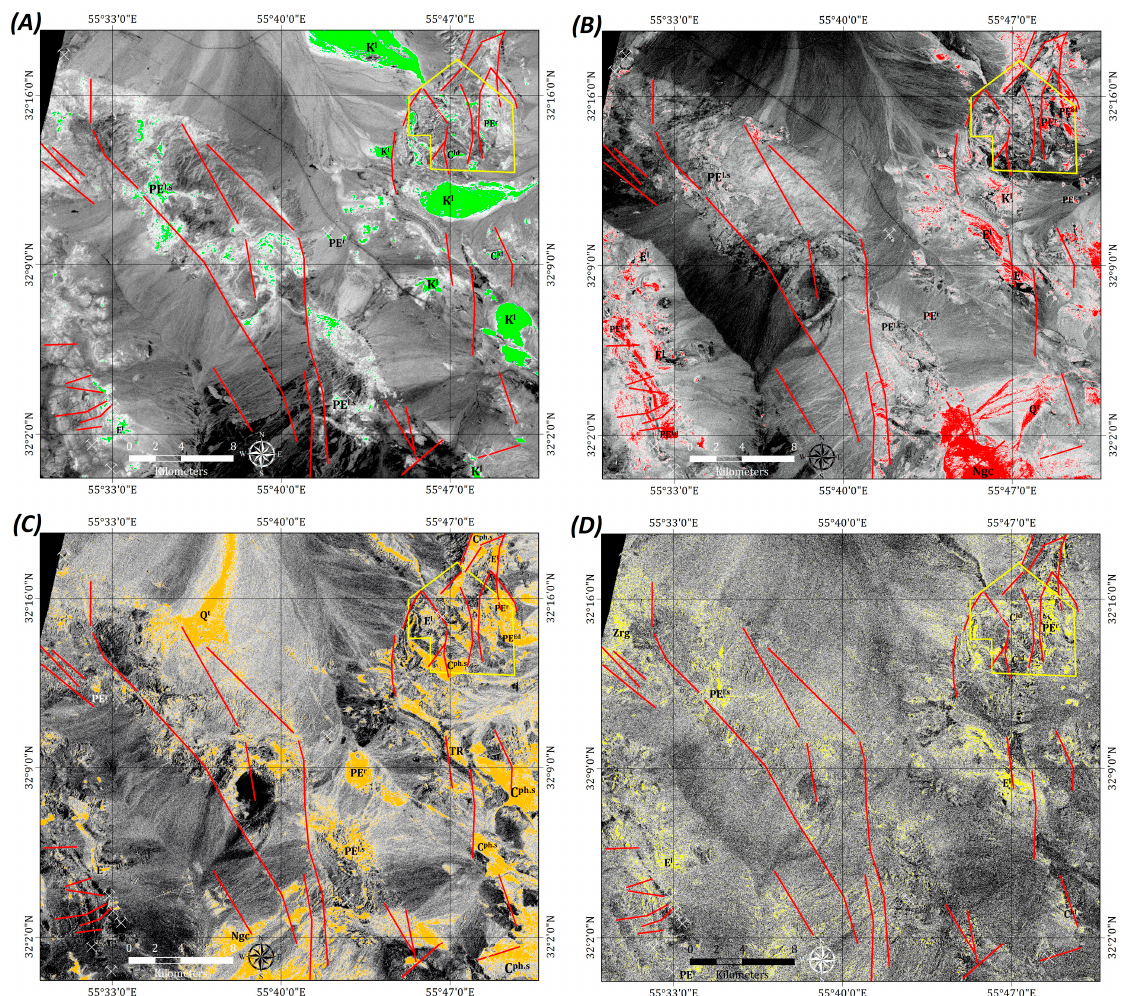
Figure 9. The PC image-maps of ASTER. ( A ) The PCA3 image-map showing Mg-Fe-OH / CO3 minerals as green pixels; ( B ) the PC4 image-map showing iron oxide / hydroxides minerals as red pixels; ( C ) the PC5 image-map showing OH / S-O / CO3-bearing minerals as mustard pixels; ( D ) the PC8 image-map showing dolomite as yellow pixels. Yellow polygon delineates WV-3 imagery.